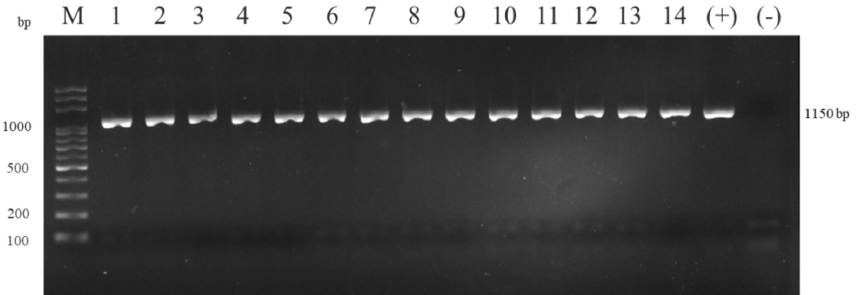
Figure 3. PCR assay of the 14 fish from the experimental group (Lanes 1–14). Pooled tissue samples (spleen and head kidney) from fish subjected to DNA extraction and PCR amplification yielding a product of 1150 bp using F11/F5 Francisella genus-specific primers after electrophoresis in 1.5% agarose gel. “M” = marker; “ − ” = negative control; “+” = positive control.